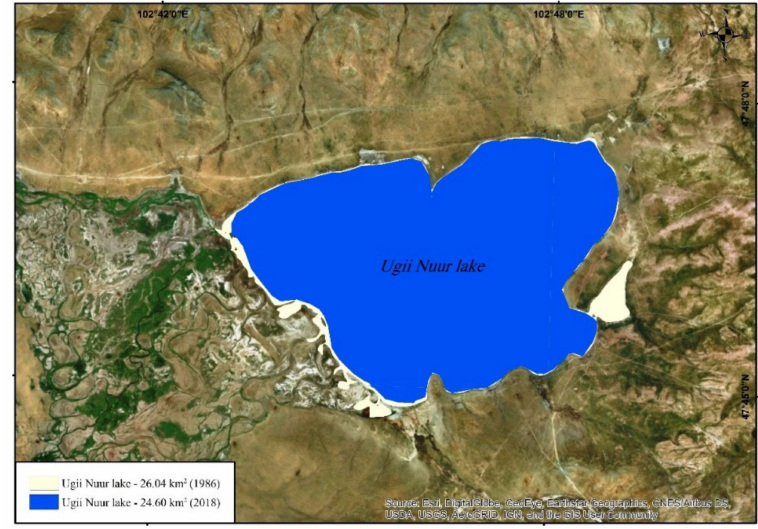
Figure 4. Spatiotemporal changes in the water surface area of the Ugii Nuur Lake from 1986 to